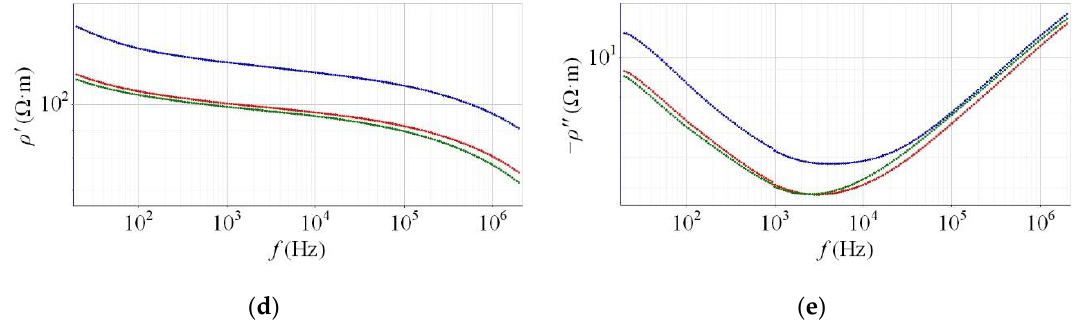
Figure A3. Impact of changes in dry density on measured complex resistivity of substrate. ( a ) Nyquist plots; ( b ) magnitude spectra; ( c ) phase spectra; ( d ) in-phase conductivity spectra; ( e ) quadrature conductivity spectra. For the spectra marked by different colors, the variable dry densities are provided in ( a ), while the related volumetric water contents (Table 3) are considered to be nearly equal. The frequency range is from 20 Hz to 2 MHz.